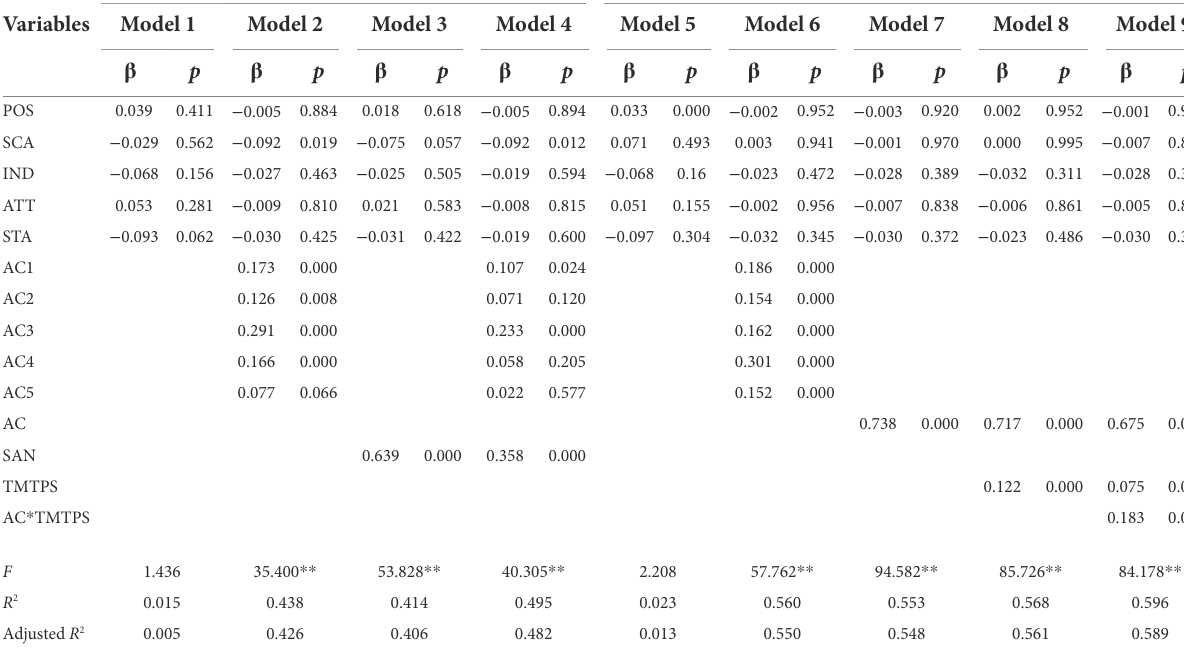
TABLE 5 Results for hypotheses testing.